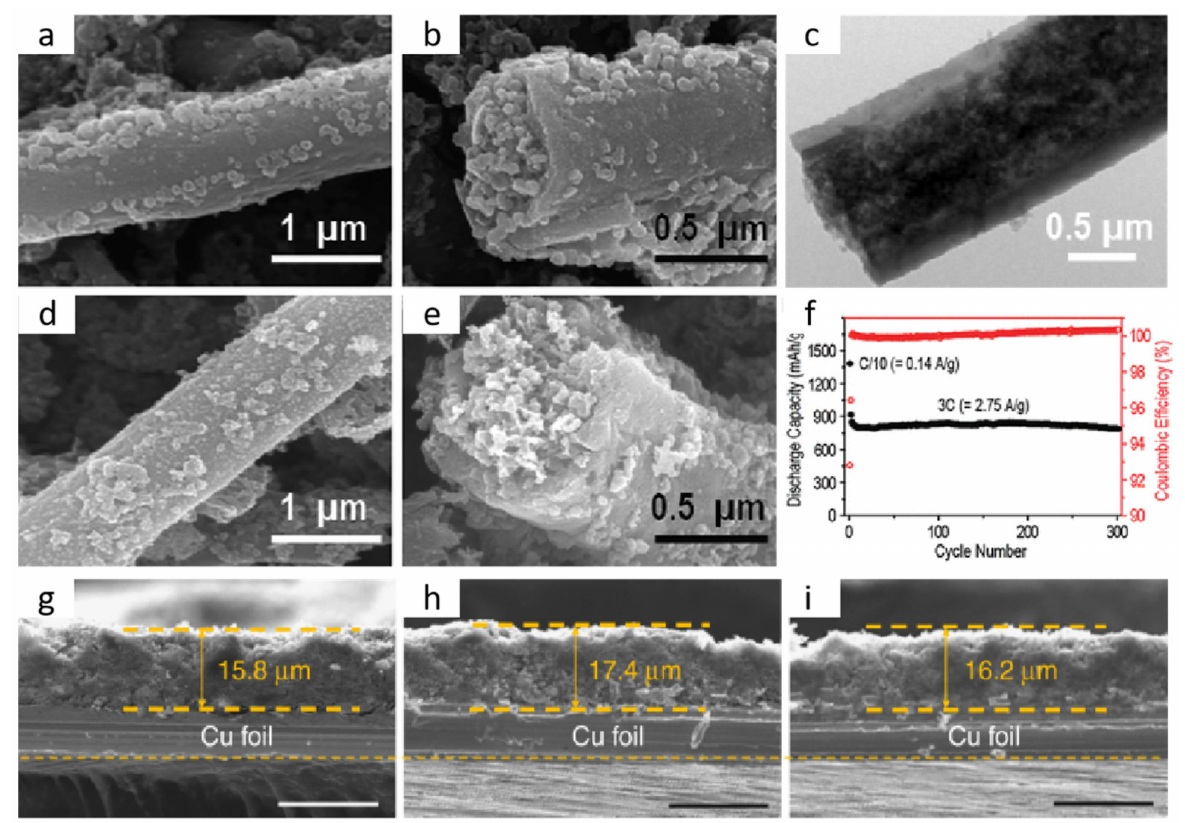
Figure 8. ( a – d ) SEM images of SiNP@C after cycling. ( a , b ) SEM images of the sidewall and the cross-section of SiNP@C after 50 cycles, ( c – e ) SEM images of the sidewall and the cross-section of SiNP@C after 500 cycles, ( f ) cycling performance of SiNP@C measured at 3C rate (2.748 A/g) Reprinted with permission from Ref. [130]. 2012, ACS Publications; electrode swelling measurements of AMPSi@C; ( g – i ) cross-sectional SEM images of the AMPSi@C electrode films ( g ) before cycling, ( h ) after full lithiation, and ( i ) de-lithiation, respectively. Reprinted with permission from Ref. [131]. 2019,